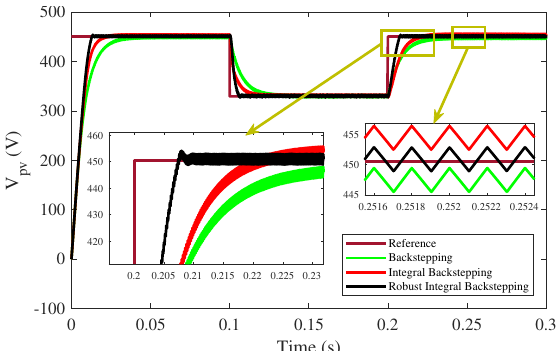
Figure 8. Output voltage of PV array under varying temperature and irradiance.